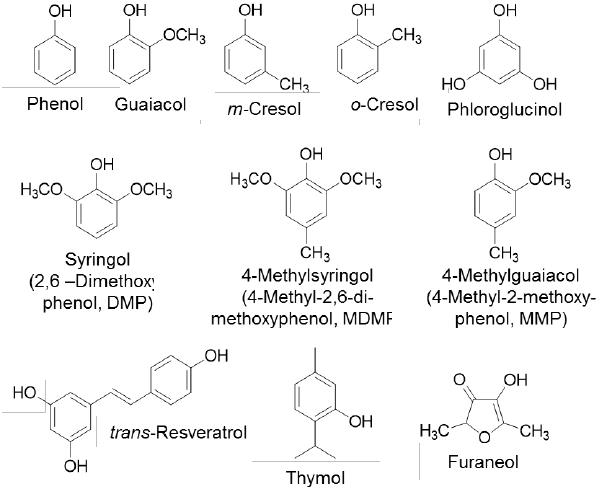
Figure 2. Chemical structures of substrates that were utilized in the detection of kinetic properties of